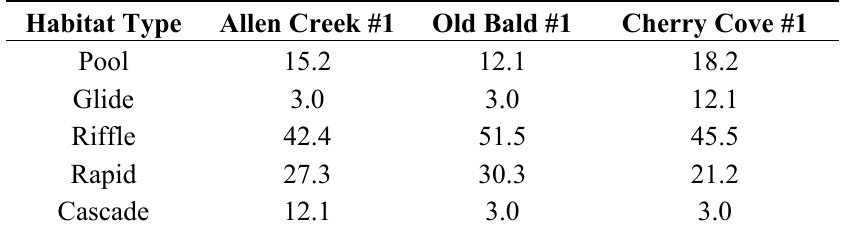
Table 2. Frequency distribution of aquatic habitats shown as a percent of the total surveyed area of channel bed recorded at the three upstream monitoring sites.